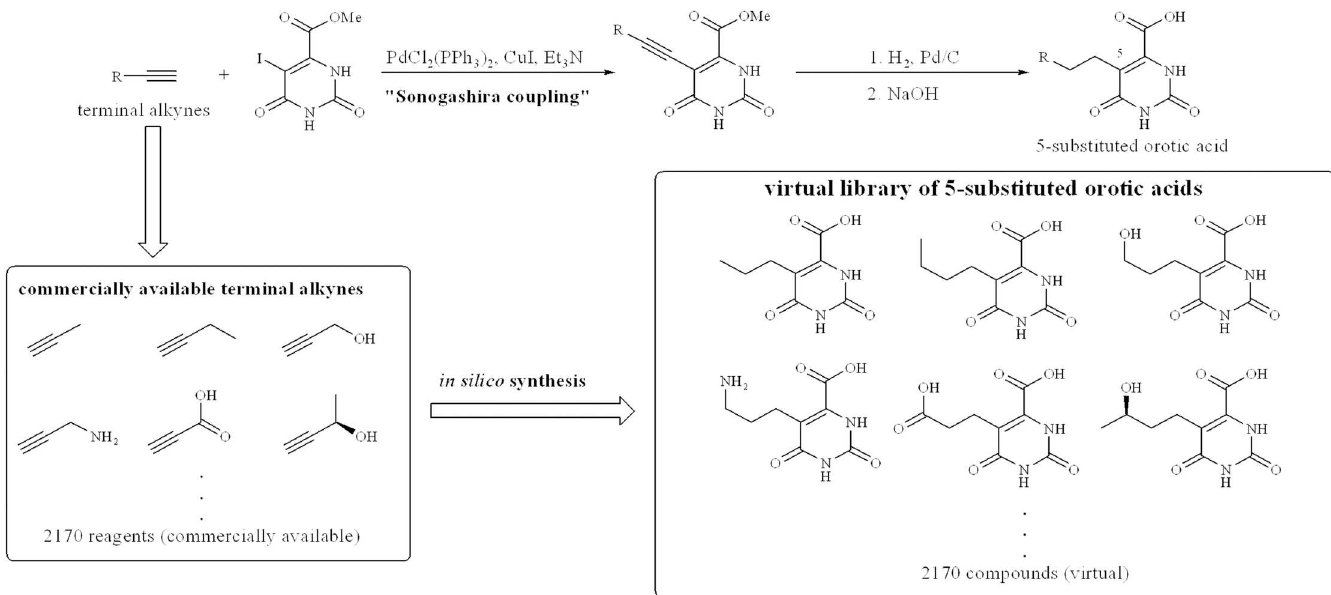
Fig 3. Virtual library of 5-substituted orotate derivatives. 5-Substituted orotate derivatives can be synthesized by Sonogashiracouplingusing terminal alkynes. A virtual library was generated in silico using all 2170commerciallyavailable terminal alkynes, screenedagainstthe more OF TcDHODH- 1 crystal structure and clusteredinto groups accordingto their dockingscores. 20 compoundswith high dockingscores were selectedand